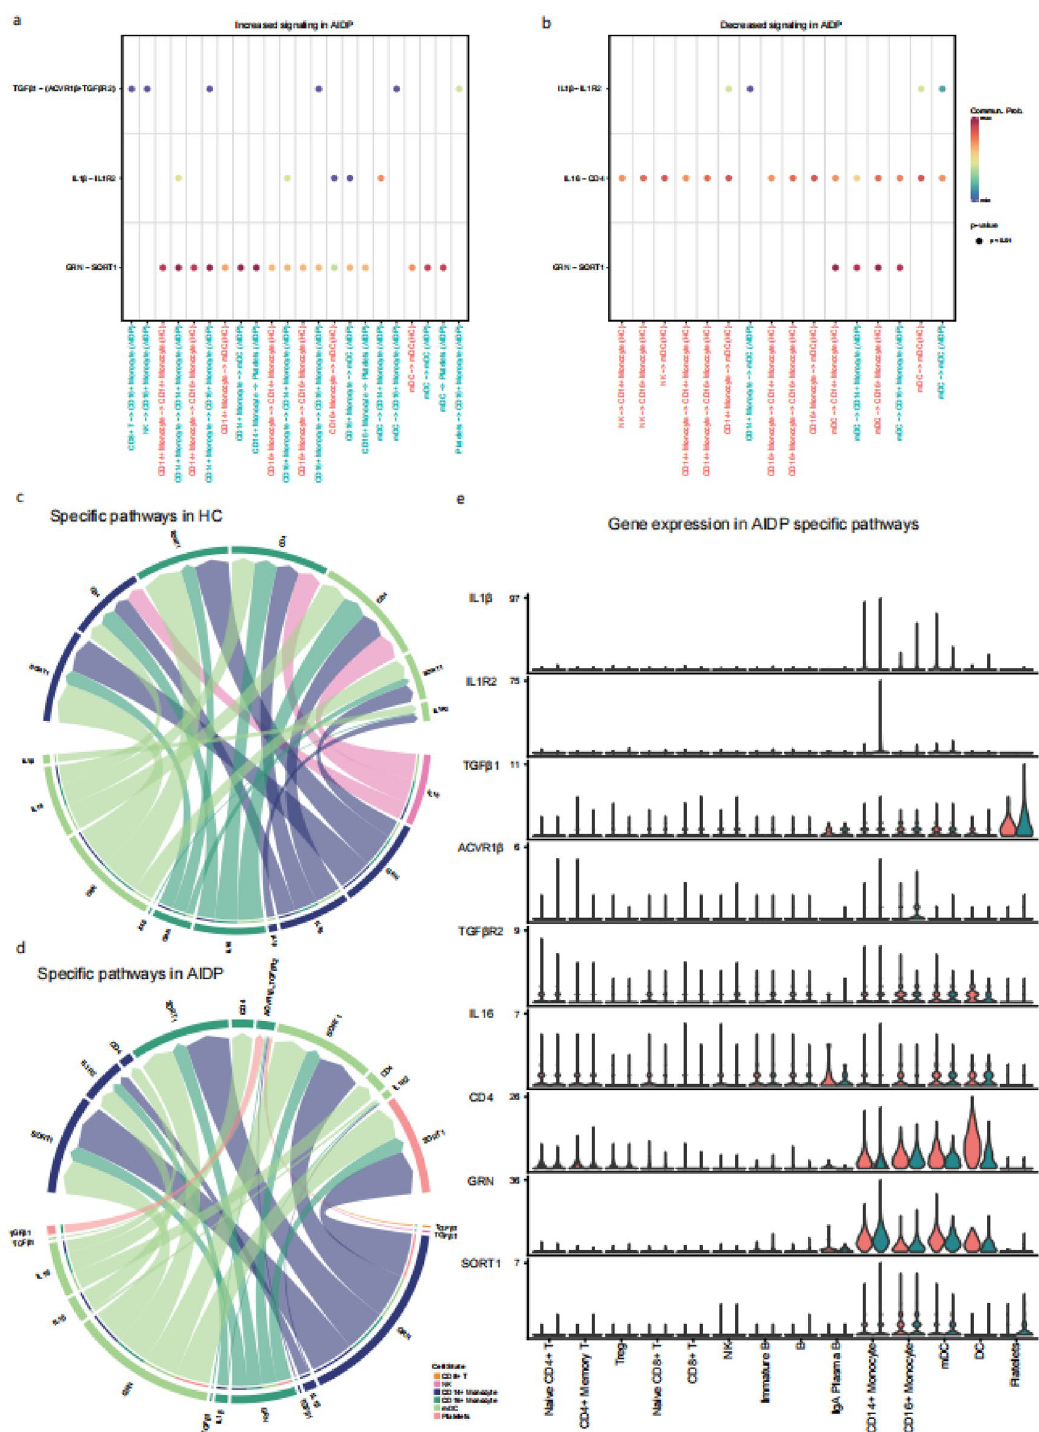
Figure 4. The specific signaling pathways in AIDP patients. a-b. Bubble plot of increased ( a ) and decreased ( b ) signaling in AIDP patients. Signaling and cell types containing AIDP specific are screened as the source and target components. X axis represents the source and target cell types, Y axis represents signaling pathways, the color scale of points represents the communication probability. ( c , d ) Chord diagram of signaling ligand- receptor pairs in HC and AIDP patients. Signaling and cell types containing AIDP specific are screened as the source and target components. The color of arrows represents the source cell types, the thickness of arrows represents the proportion of the signaling. ( e ) Gene expression of AIDP specific signaling ligand-receptor pairs between HC and AIDP patients. Violin plots show the distribution of expression levels of each cell